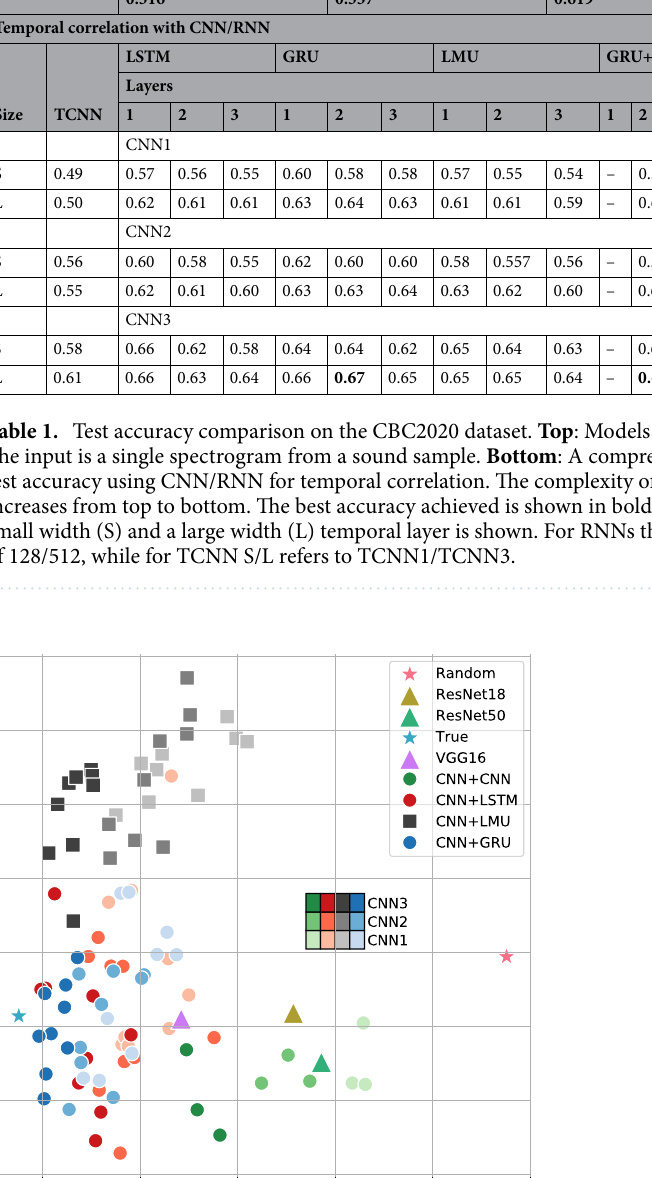
the following manner. First, for each trained model, the softmax outputs of all the test samples are concatenated. Second, the concatenated softmax vectors are then projected along the two dimensions with the maximum variance by performing Principal Component Analysis (PCA). We observe that the hybrid models with CNN for both representation and temporal components are clustered together with the stand-alone models, and are different from the hybrid models that use RNNs for the temporal component. The hybrid models with RNNs